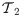
The transformation T2 in Case 2 of Theorem 18.